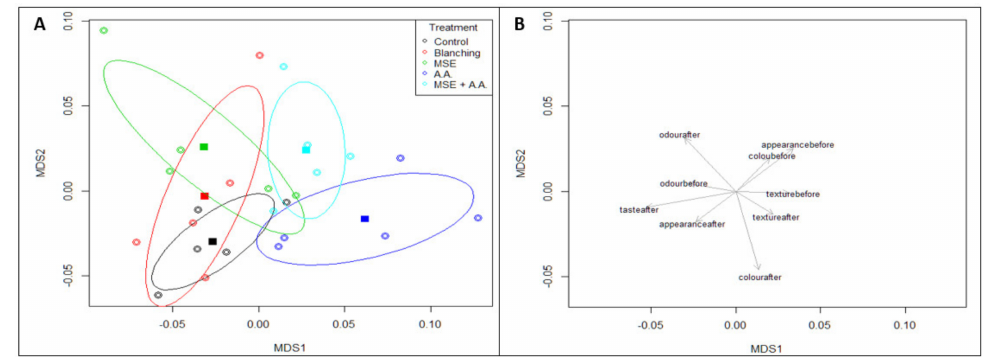
Figure 6. Non-metric multidimensional (NMDS) scaling for sensory parameters using mono-MDS. Circular points are replicates, solid square points are centroids for the data ellipses (by treatment) ( A ). Arrow plots showing weightings for sensory scores ( B